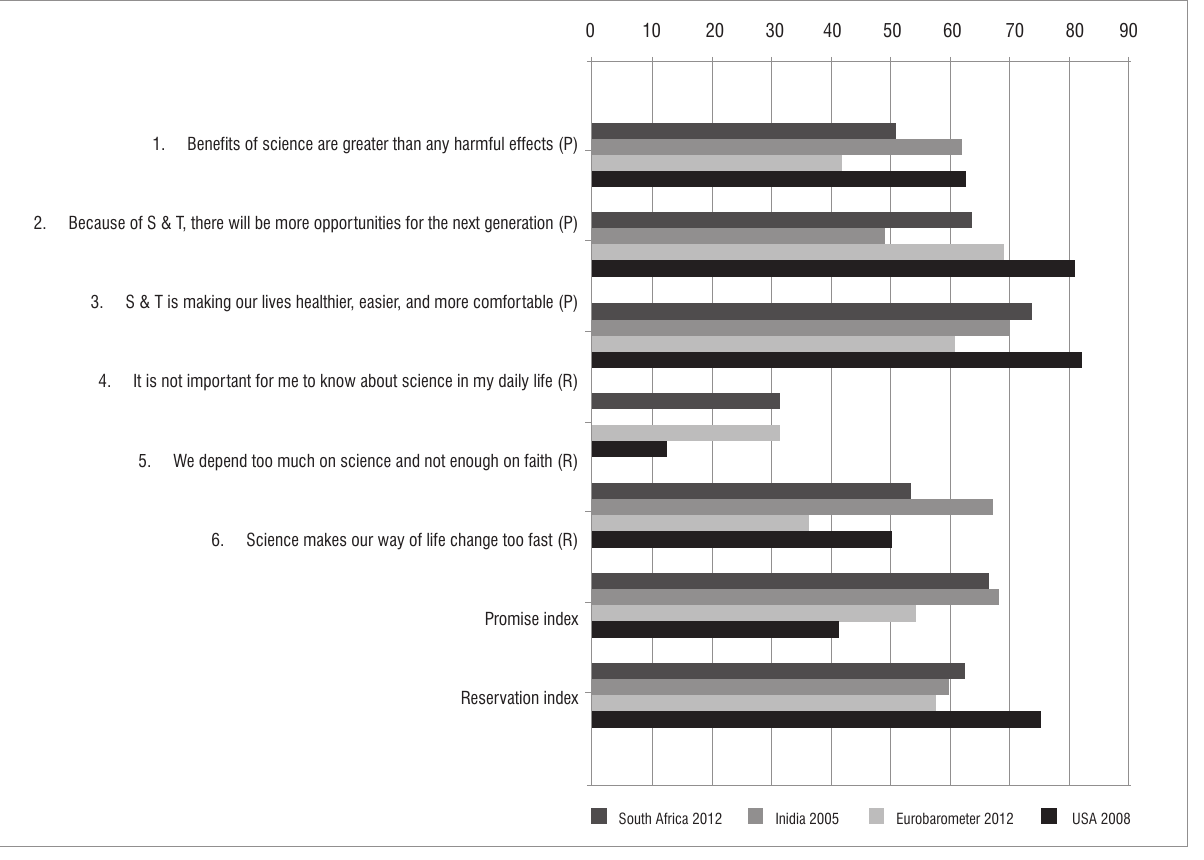
Figure 2: Comparison of performance on promise-reservation items among South Africa, Europe, India and the